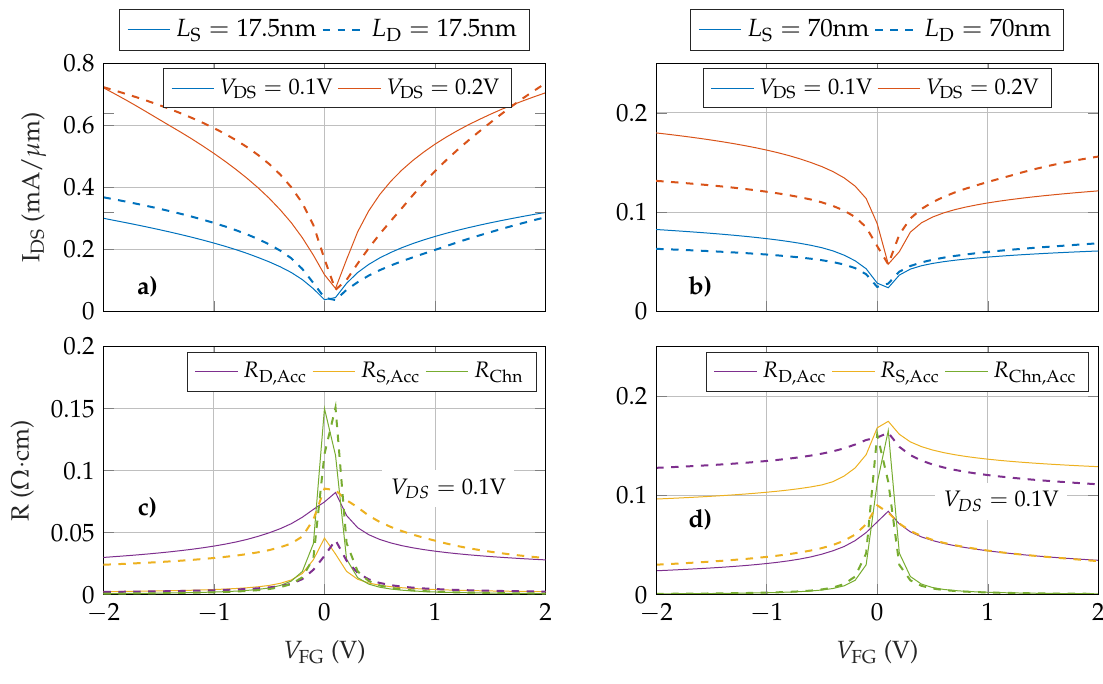
Figure 5. Transfer response ( a , b ) and structure resistances ( c , d ) as a function of the gate bias. These results are obtained reducing the length of either the source ( a , c , solid lines) or drain access region ( b , d , dashed lines) down to 17.5 nm, and increasing the length of either the source ( a , c , solid lines) or the drain access region ( b , d , dashed lines) up to 70